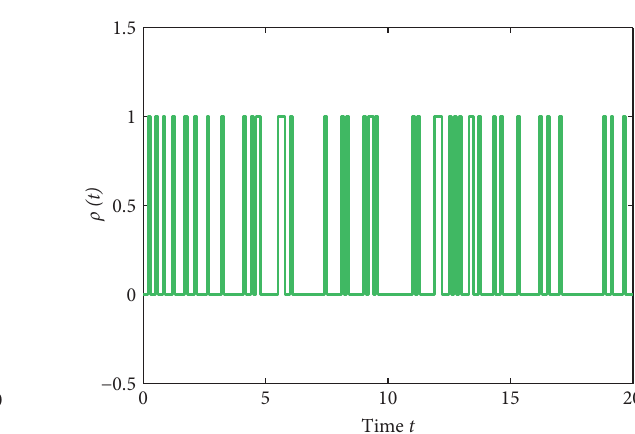
Figure 6: Bernoulli distribution.